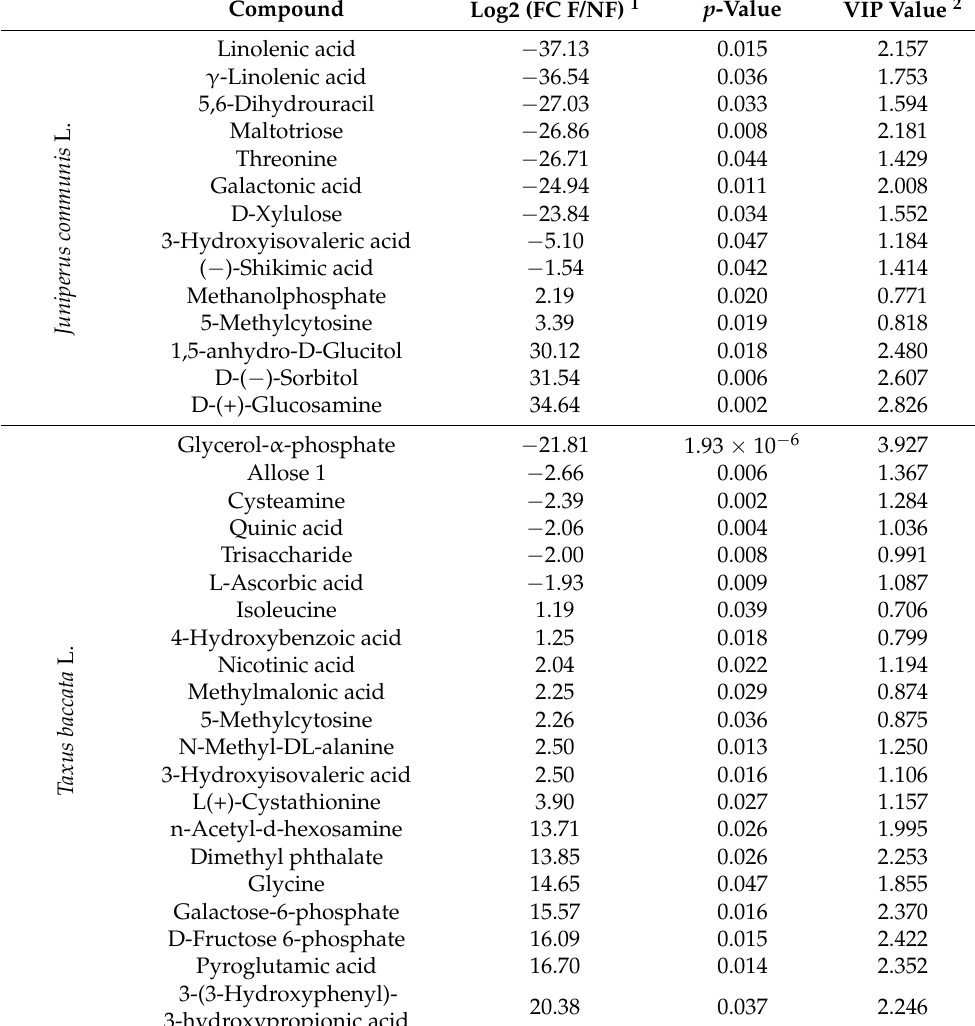
Table 1. Differential metabolites of Juniperus communis L. and Taxus baccata L. pollen grains produced by comparison between plants grown in fertilized (F) and non-fertilized (NF)